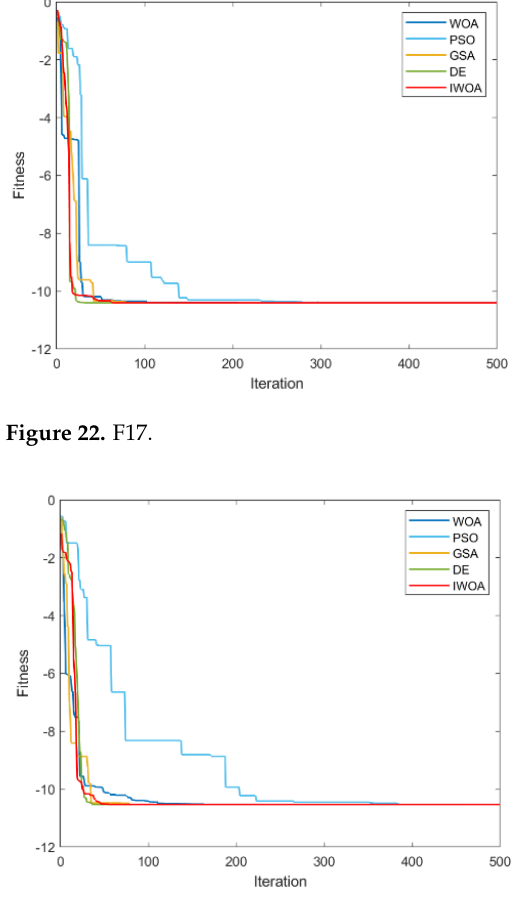
Figure 23. F18. Figure 23.